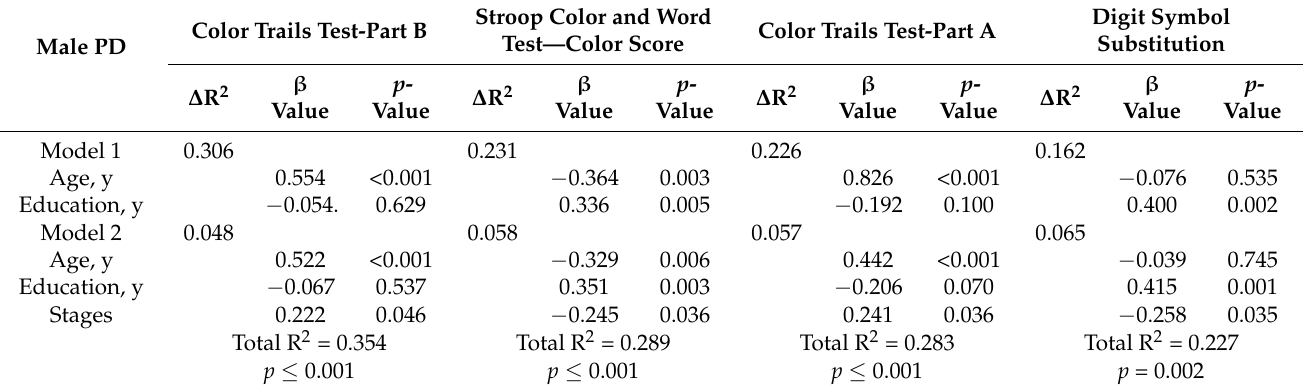
Table 6. Multiple linear regression analyses in male PD with various